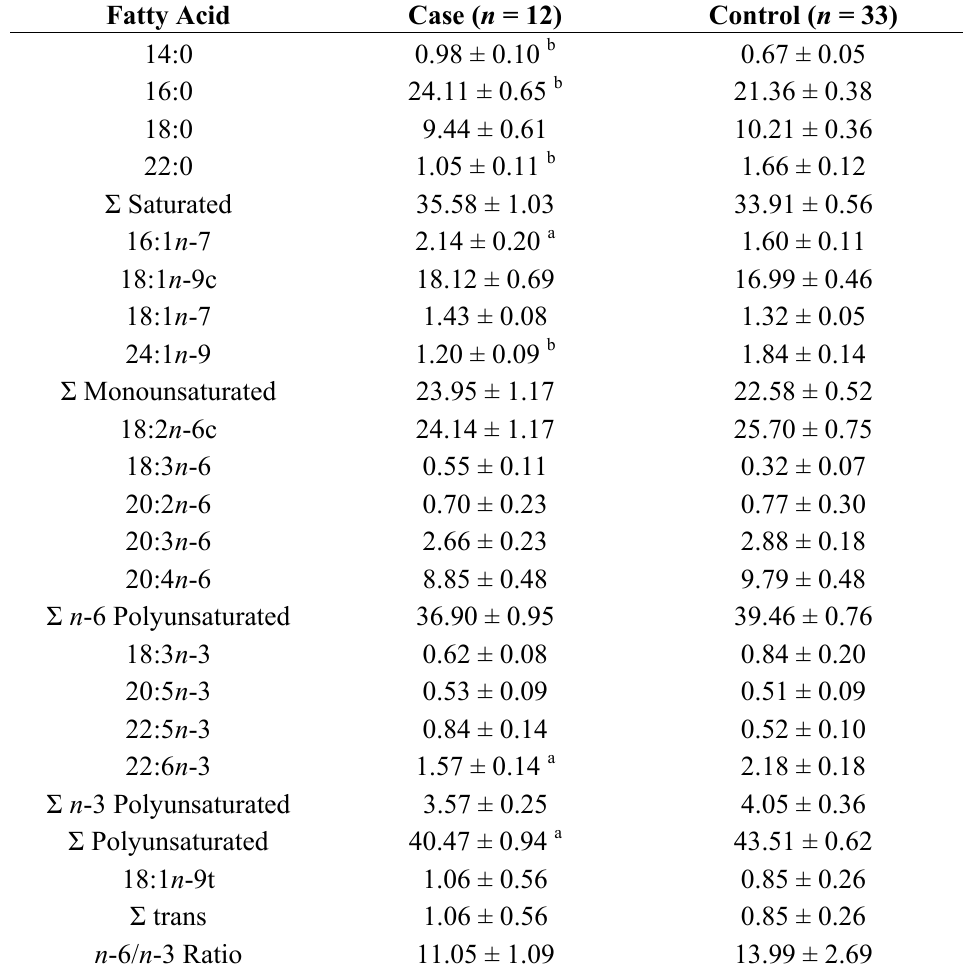
Table 2. Serum fatty acid composition of subjects expressed as the percentage (%) of total fatty acids